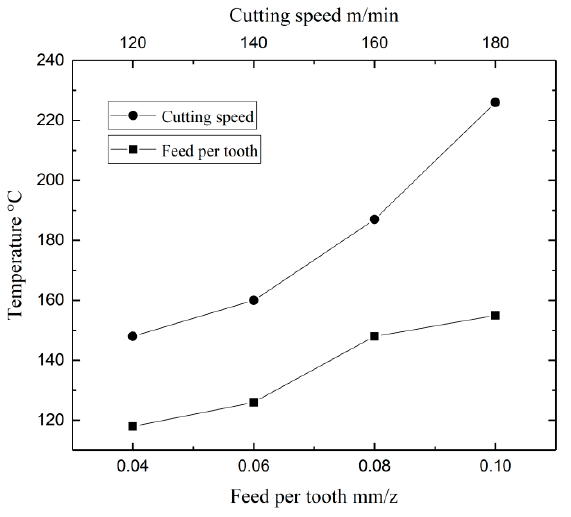
Figure 4. Changes in cutting temperature in relation to changes in the cutting parameters.